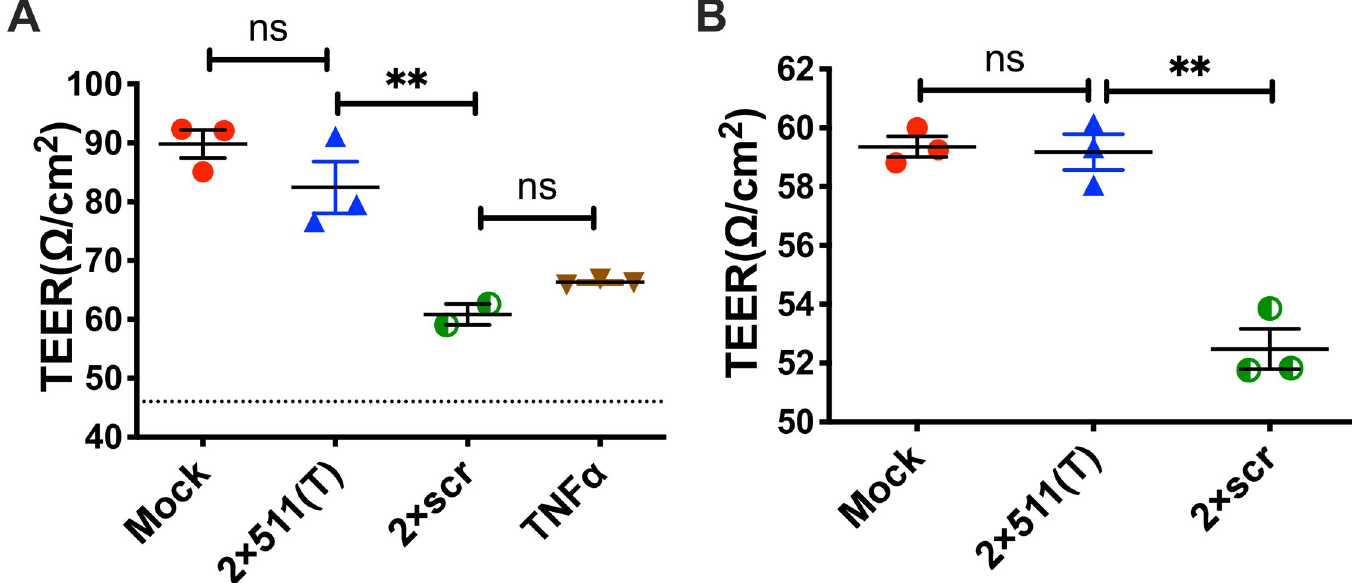
Fig 5. Soluble factors produced in the presence of ZIKV-infected macrophages can disrupt the Sertoli cell barrier. A murine Sertoli cell line, 15-P1, was grown to confluency in transwells. Cells were then exposed to testis homogenates from AG129 mice that were infected with 2 × scr (n = 2 for experiment depicted in ( A ), and n = 3 for experiment depicted in panel ( B )), 2 × 511(T) (n = 3), or mock inoculated (n = 3). One hundred nanograms of murine TNF ⍺ was also included as a positive control ( A ). A voltage was applied across the transwell 24 hours post exposure, and resistance was measured. Transepithelial electrical resistance (TEER) was calculated as ohms/cm 2 . Since 15-P1 monolayers had grown to different peak TEER values in two independent experiments, raw TEER values are reported separately ( A ) and ( B ) for two independent, double blinded experiments. Significance was determined by one way ANOVA. �� indicates p < 0.01.